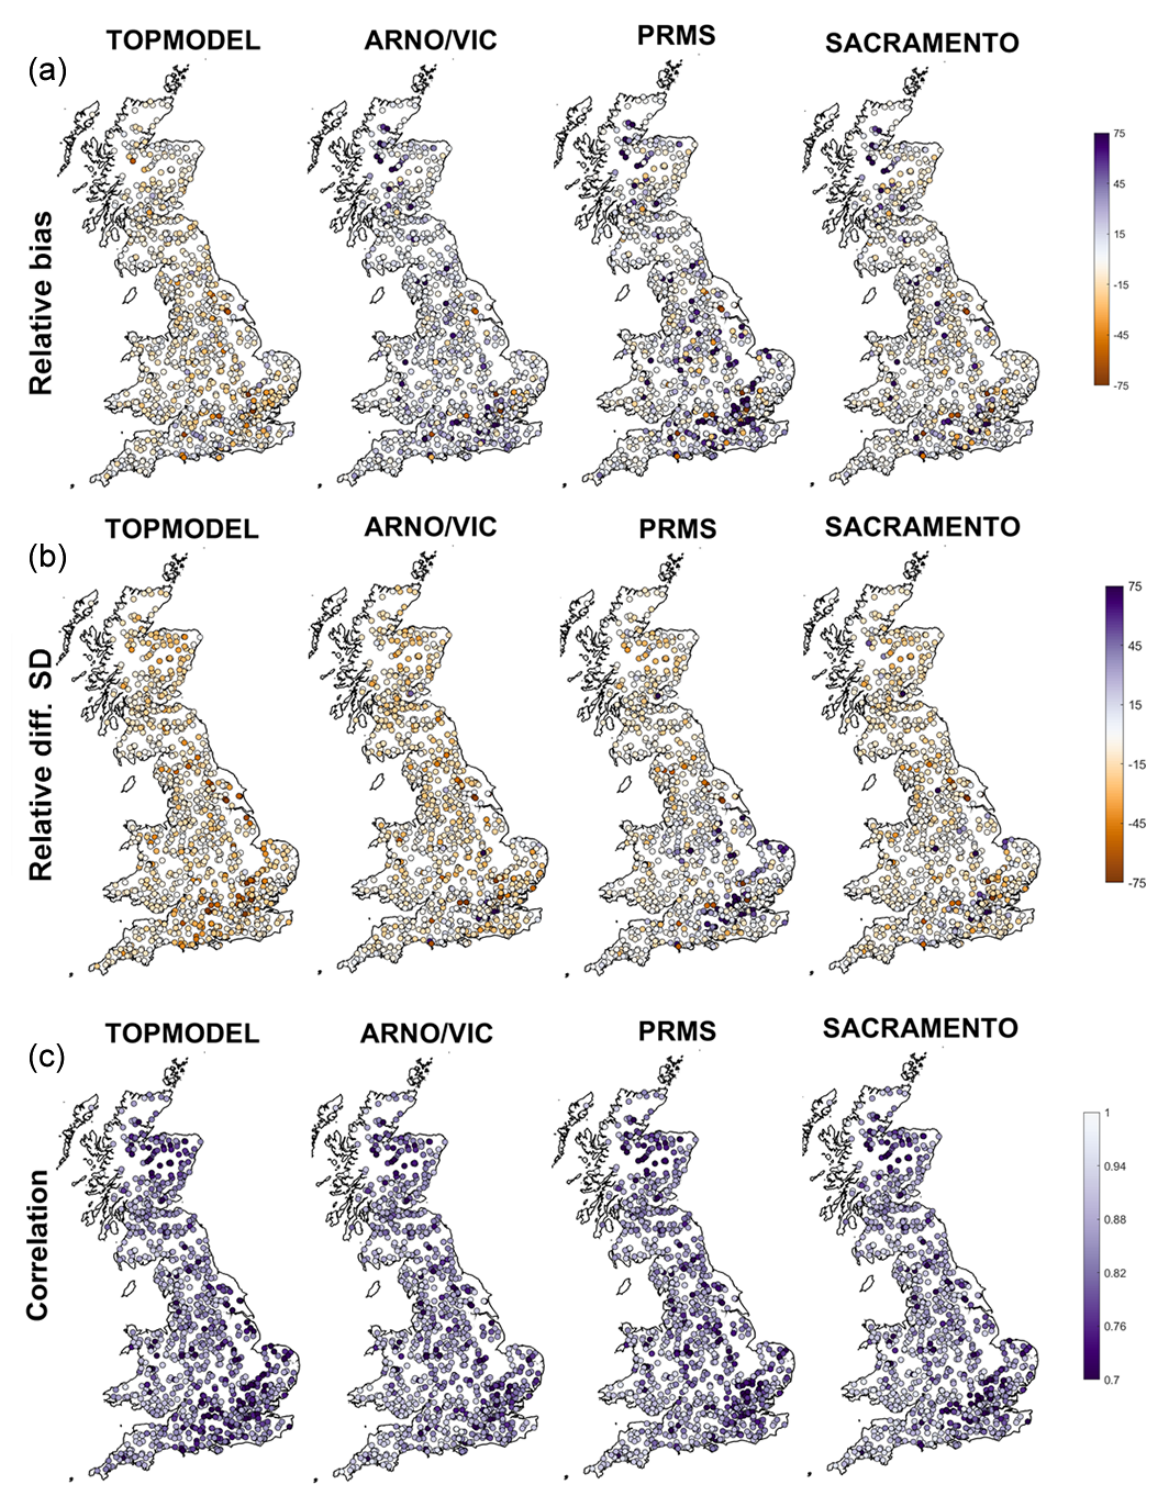
Figure 6. GB maps of model performance for each structure for three different metrics. (a) shows model relative bias or relative error in simulated mean runoff (%), (b) shows relative error in the standard deviation of runoff (%), and (c) shows correlation between observed and simulated streamflow. Each point is a gauge location, and metrics have been calculated for the simulation gaining the highest NSE for that